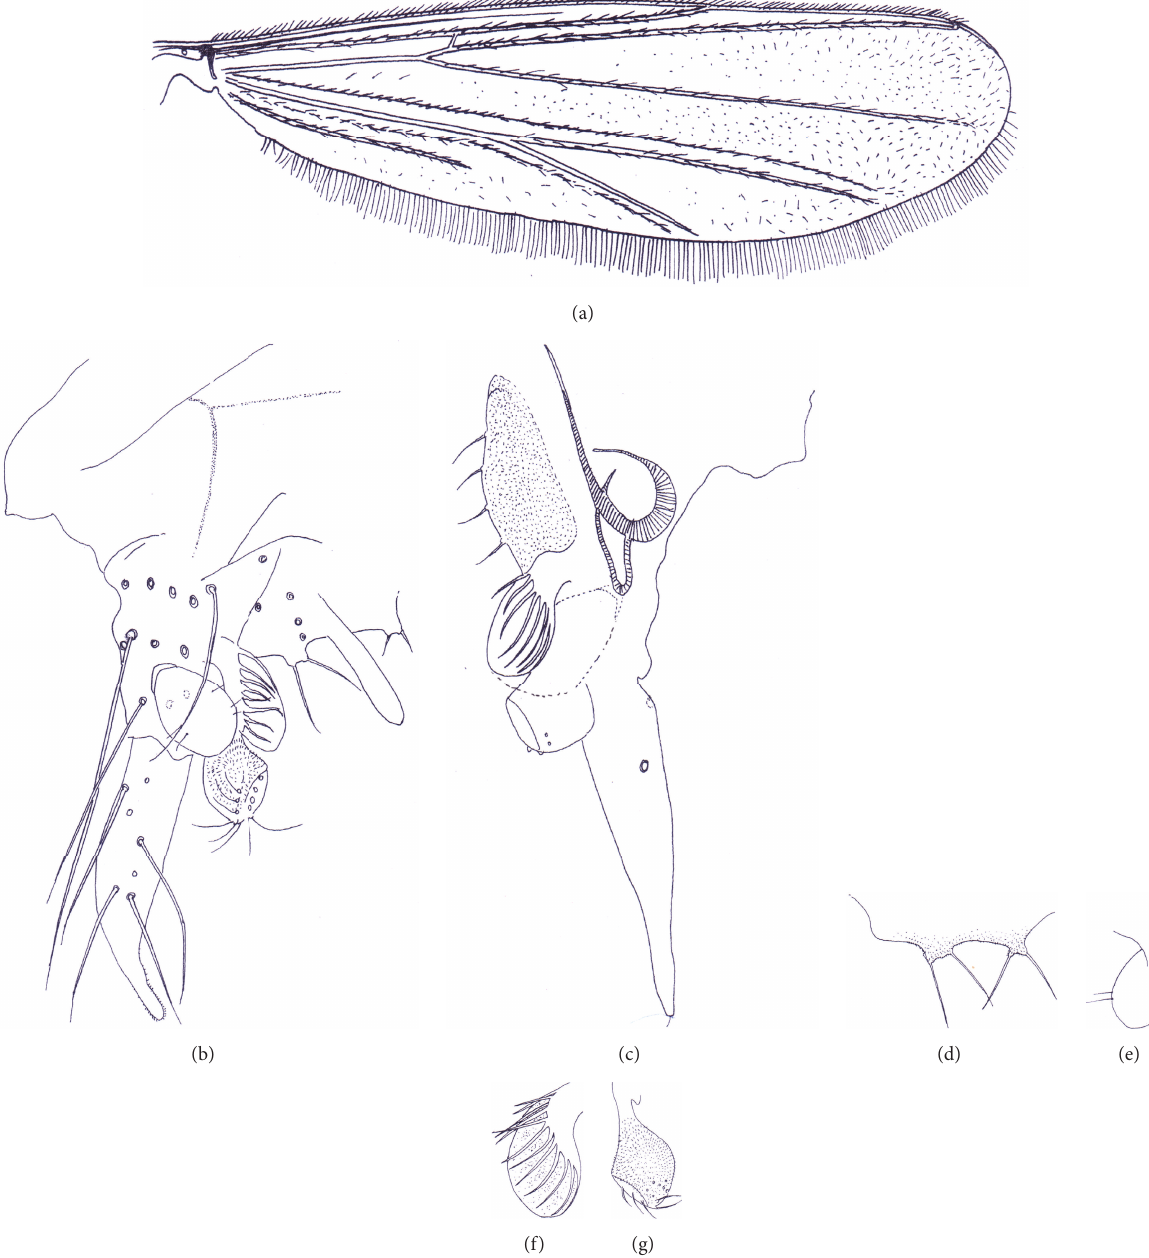
Figure 6: Rheotanytarsus caputimberus n. sp., adult male: (a) wing; (b) hypopygium (left-dorsal view); (c) hypopygium (right-ventral view); (d) shoulders at the posterior margin of tergite IX; (e) superior volsella; (f) median volsella; and (g) inferior volsella.